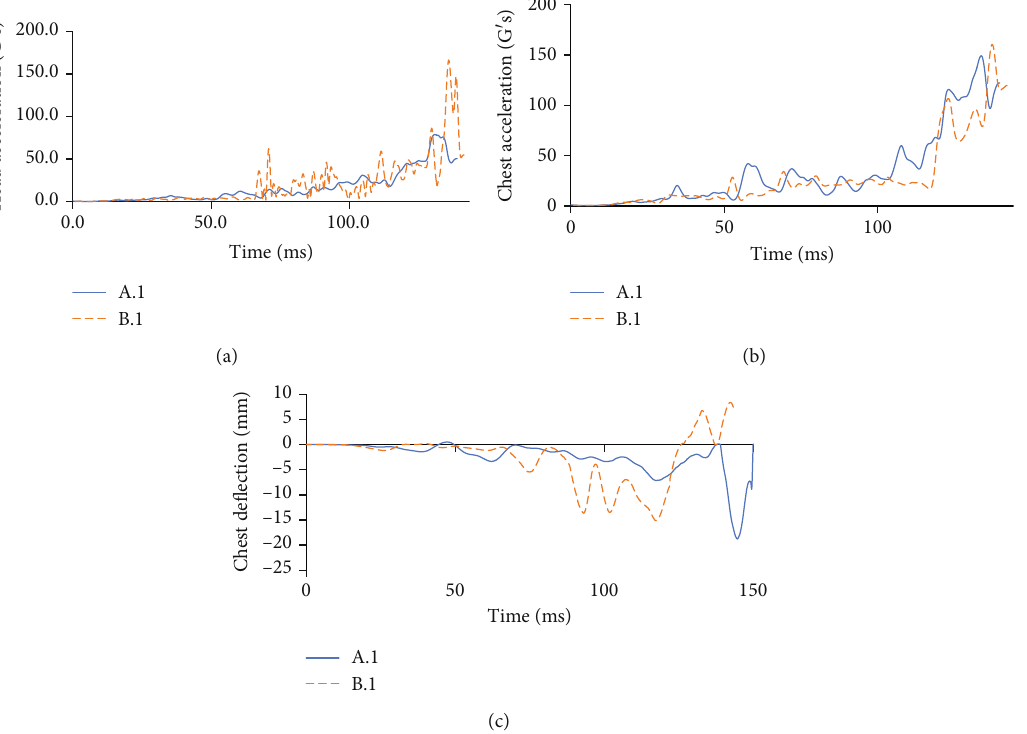
Figure 8: (a) Acceleration in the head and HIC ’ s gravity center at a speed of 60km/h. (b) Acceleration of chest gravity center in G ’ s at a speed of 60km/h. (c) Chest de fl ection in mm during a tra ffi c accident at a speed of